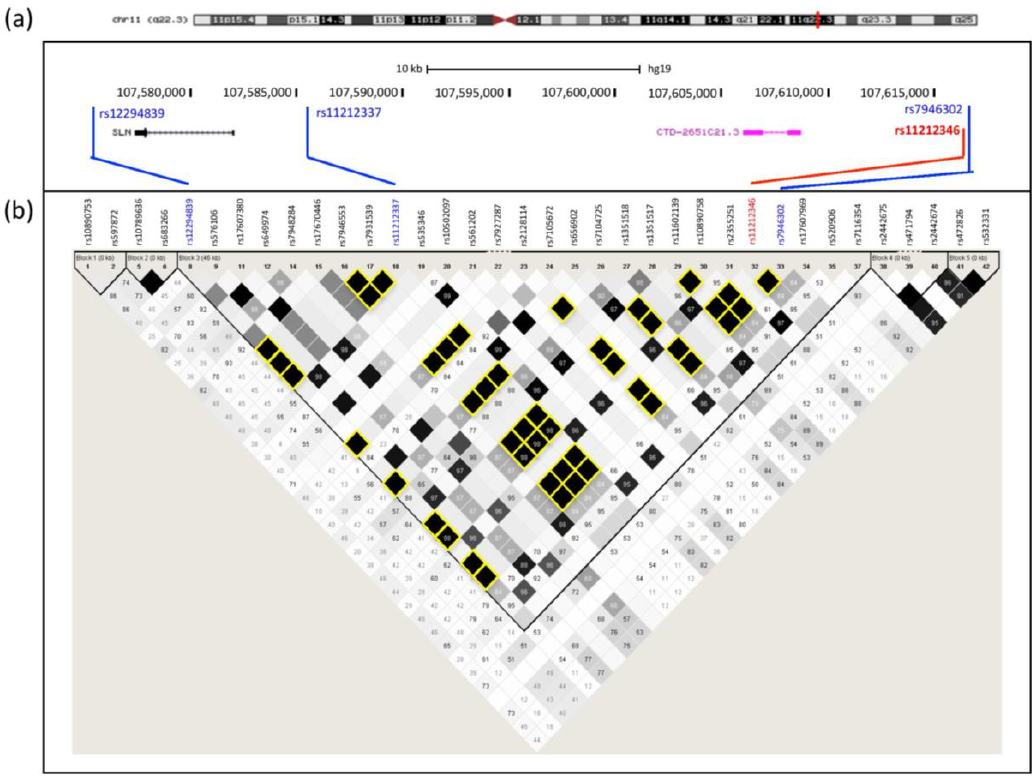
Figure 1. Linkage disequilibrium (LD) block for (fibrillin-1) FBN1 expression transregulator region at 11q22.3: ( a ) Cytogenetic localization and sequence coordinates of lead single nucleotide polymorphisms (SNPs) in red; ( b ) Regional LD map. Data were extracted from HapMap using Haploview. Linkage disequilibrium was measured as r 2 values which range from 0 (no correlation) to 1 (complete correlation). SNPs in complete LD ( r 2 = 1) with SNPs identified by eQTL analysis are highlighted in